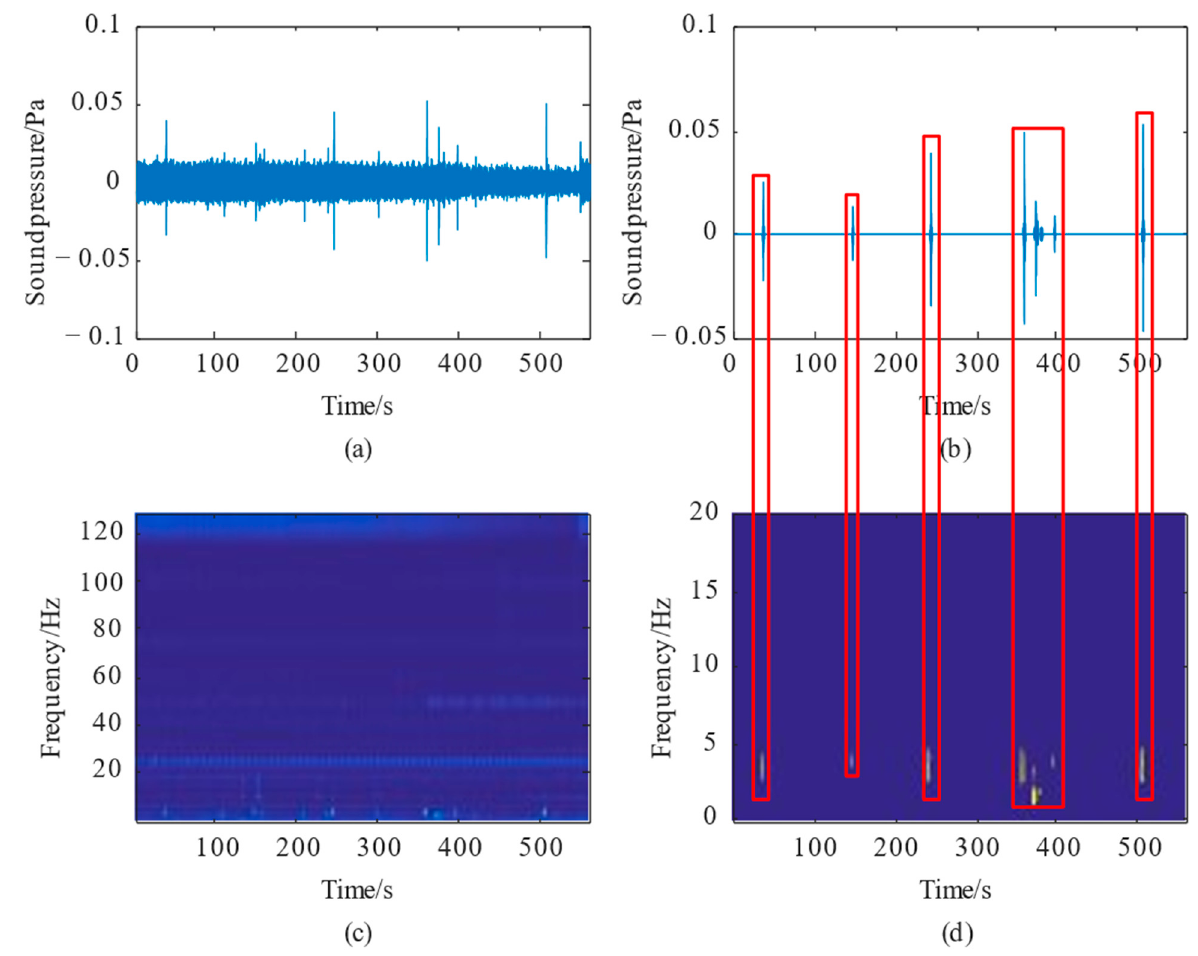
Figure 5. Signals before and after background noise processing. ( a ) Original signals, ( b ) signals after background noise processing, ( c ) time-frequency spectrum of the original signals, ( d ) time-frequency spectrum after background noise processing.